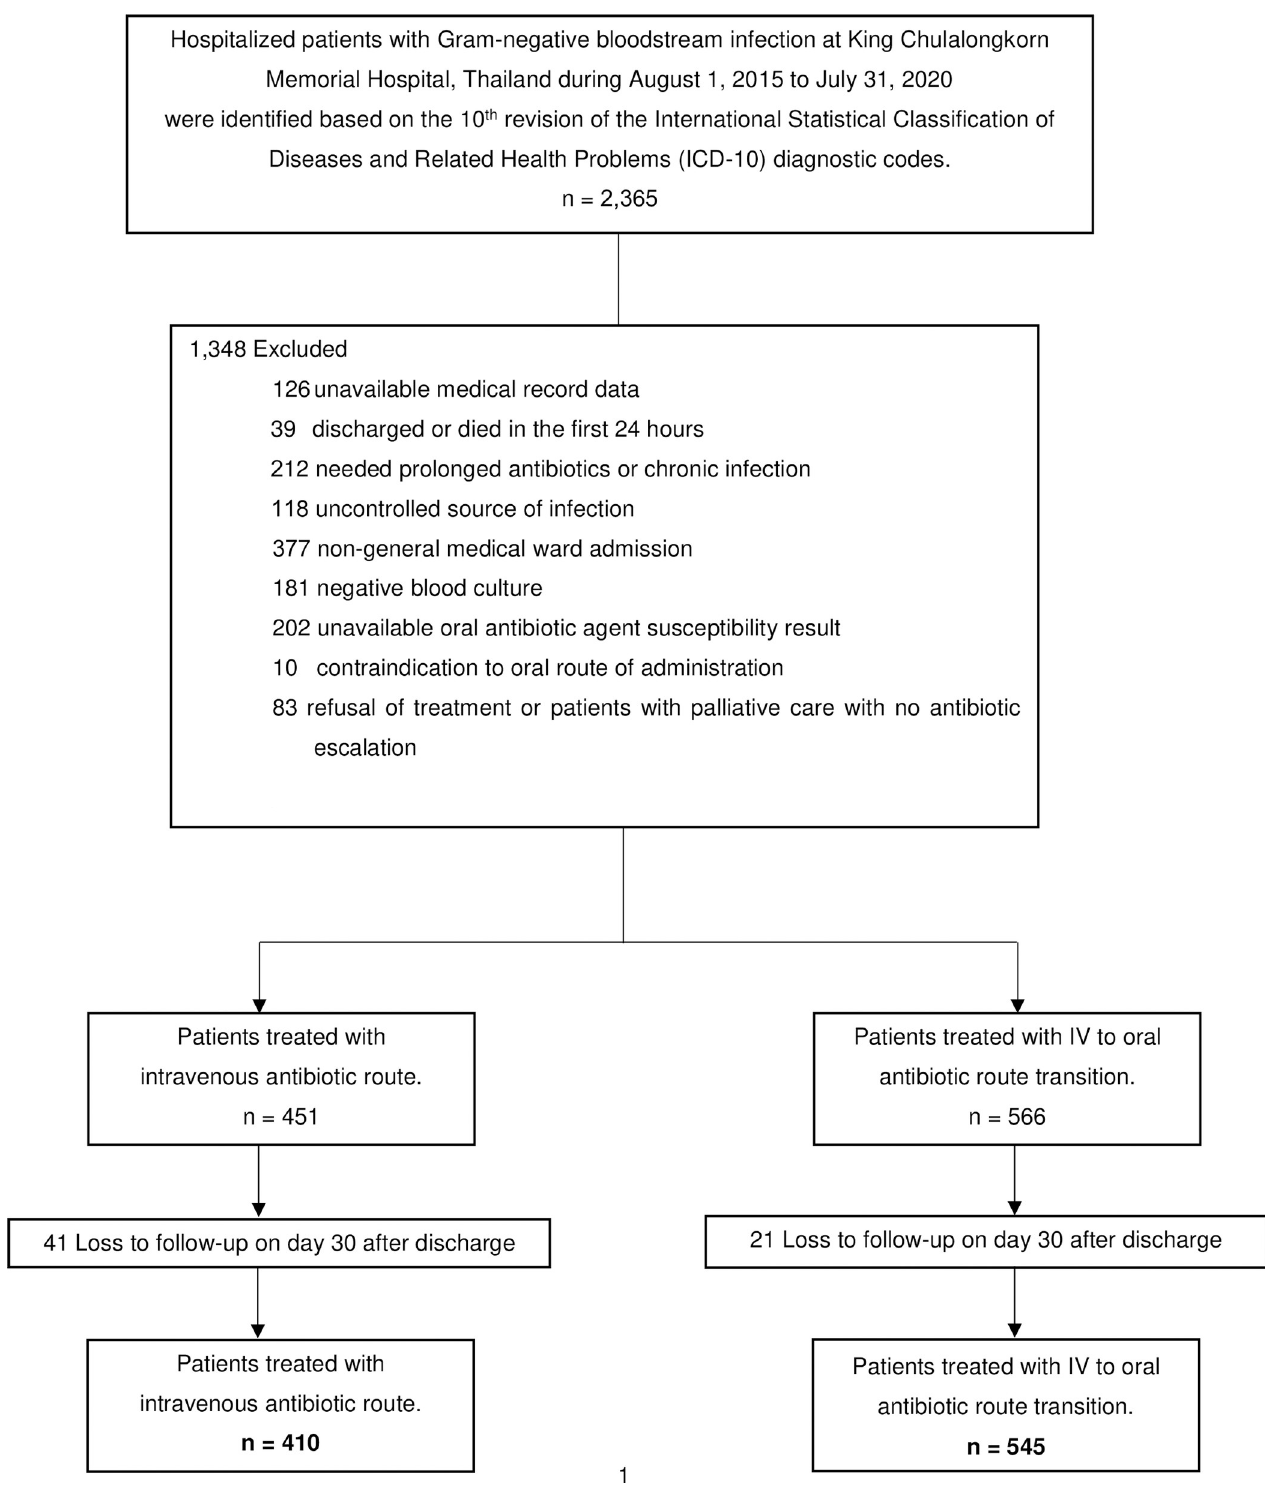
Fig 1. Flow diagram for patient selection.